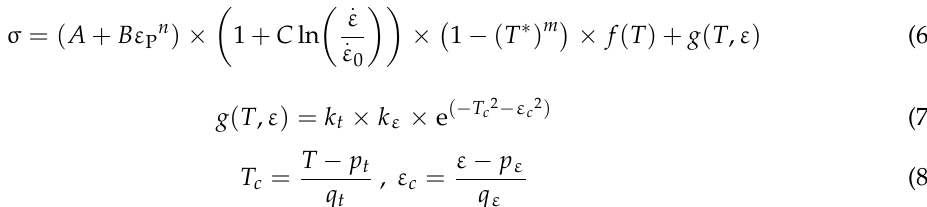
Figure 6. Comparison of experimental data and J-C model ( a ) quasi-static at 25 °C; ( b ) at different strain rate and 25 °C; ( c ) at different strain rate and 600 °C; ( d ) at different strain rate and 900 °C.